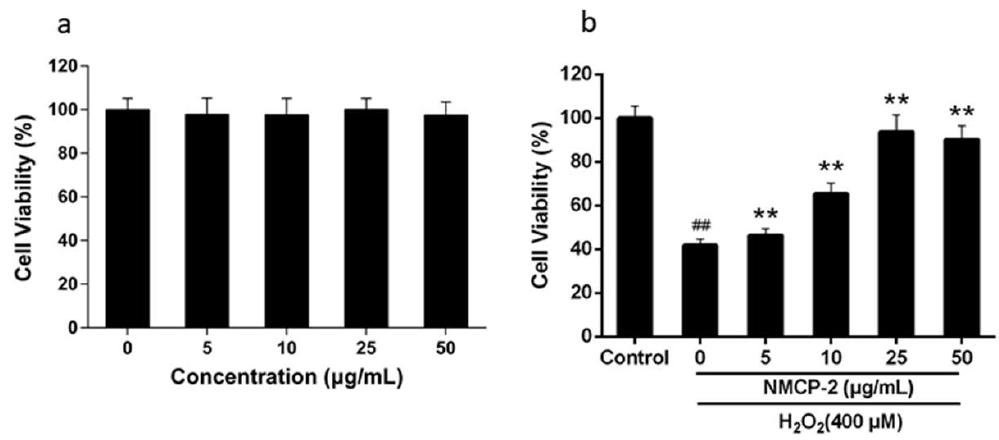
Figure 6. Effects of NMCP-2 and H 2 O 2 on the cell viability of HEK 293T cells. ( a ) Effects of NMCP-2 on the HEK 293T cell survival rate. ( b ) Protective effects of NMCP-2 against oxidative damage induced by H 2 O 2 . Data are expressed as the mean ± standard deviation. ## p < 0.01 differs from control group; ** p < 0.01 differs from model group.